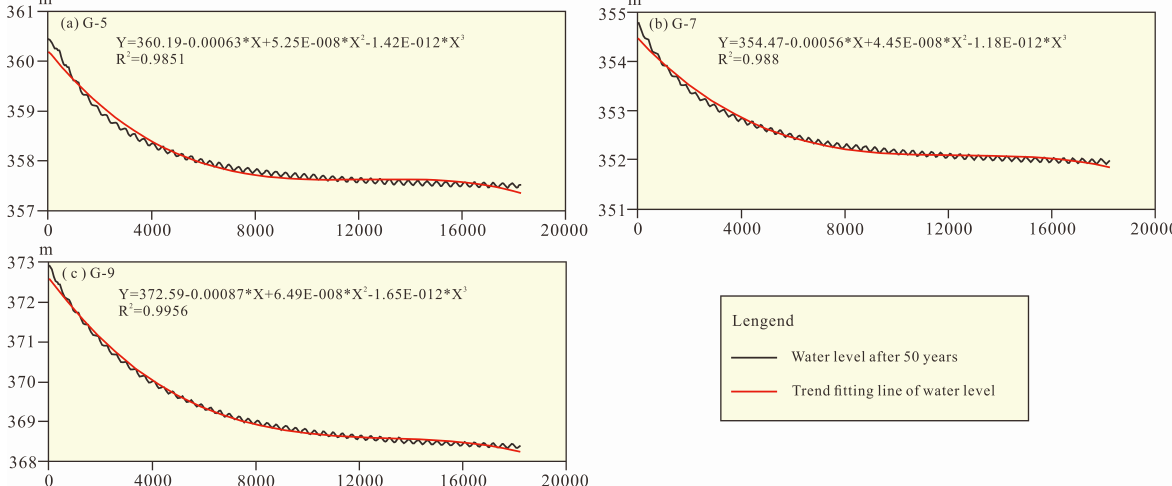
Figure 12. Maps that show the trend in change in the water level of ( a ) G-5, ( b ) G-7, and ( c ) G-9 observation wells for scenario